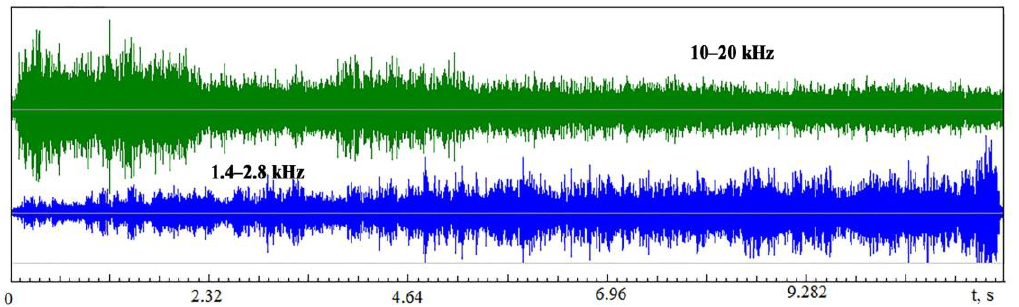
Figure 16. Records of VA signal in time in two frequency ranges from the machining start to the electrode breakage.